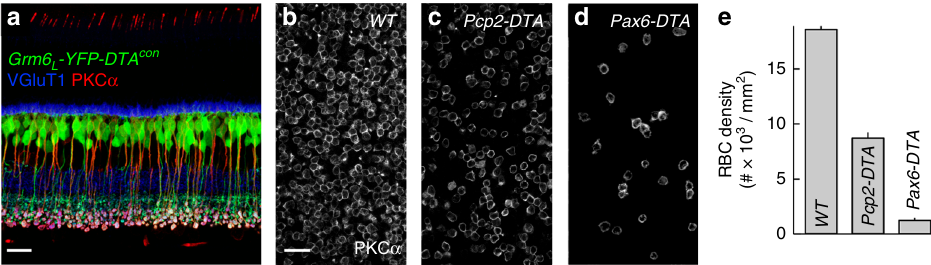
Fig. 3 Transgenic removal of RBCs from developing circuits. a Section through a Grm6L-YFP-DTA con retina in which ON bipolar cells express YFP (green) stained for VGluT1 (blue), which labels photoreceptor and bipolar cell axon terminals, and for the RBC-speci fi c marker PKC α (red). Scale bar indicates 20 μ m. b – d Retinal fl at mounts from wild-type ( b ), Pcp2-DTA ( c ), and Pax6-DTA ( d ) mice stained for PKC α . Scale bar indicates 20 μ m. e Summary data (mean ± SEM) of RBC densities in wild-type ( n = 23 mice), Pcp2-DTA ( n = 8 mice), and Pax6-DTA ( n = 22 mice) mice. By Kruskal – Wallis one-way ANOVA testing, the density of RBCs was lower in Pcp2-DTA and Pax6-DTA compared to wild-type retinas ( p < 0.04 and p < 10 − 8 , respectively), and lower in Pax6- DTA than in Pcp2-DTA retinas ( p <